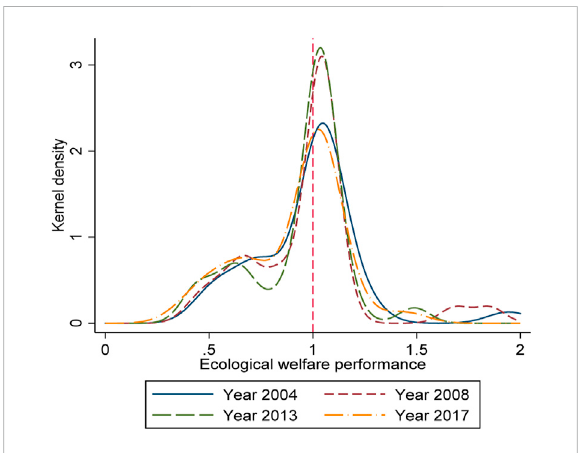
FIGURE 3 Kernel nuclear density estimation of China ’ s Ecological well- being